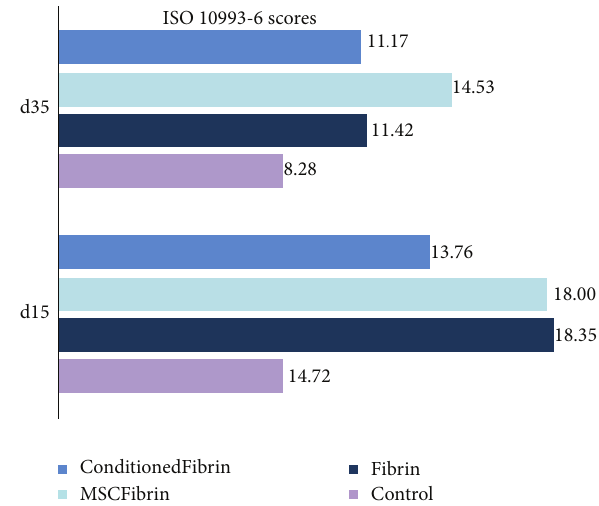
Figure 4: ISO 10993-6 scoring for the Control and treatment groups (after choosing fibrin glue—Tisseellyo as the preferred vehicle) tested at d15 and